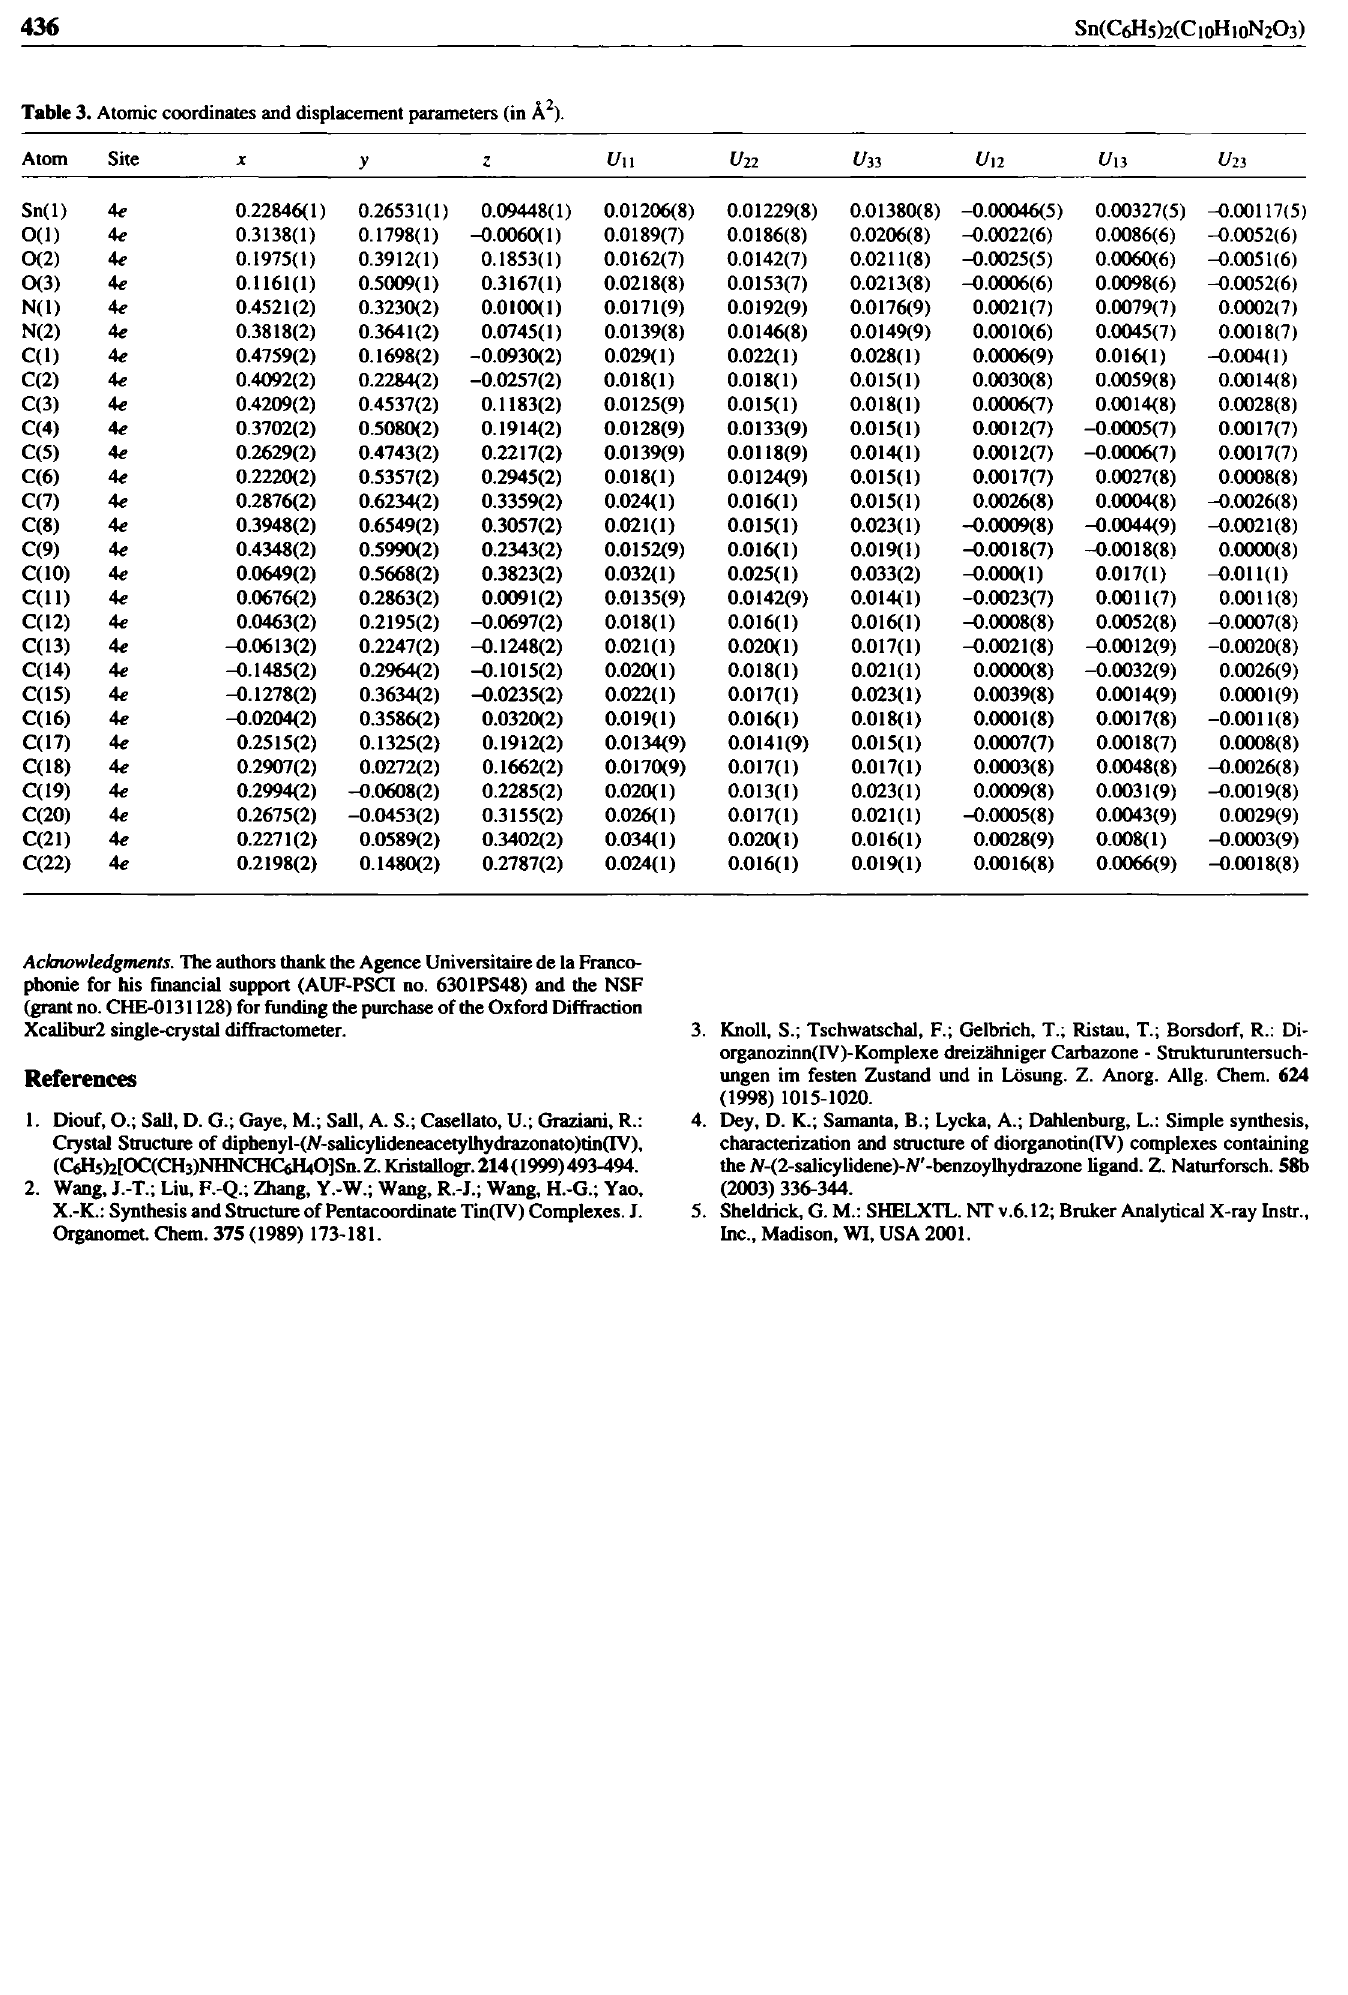
Table 3. Atomic coordinates and displacement parameters (in Â 2